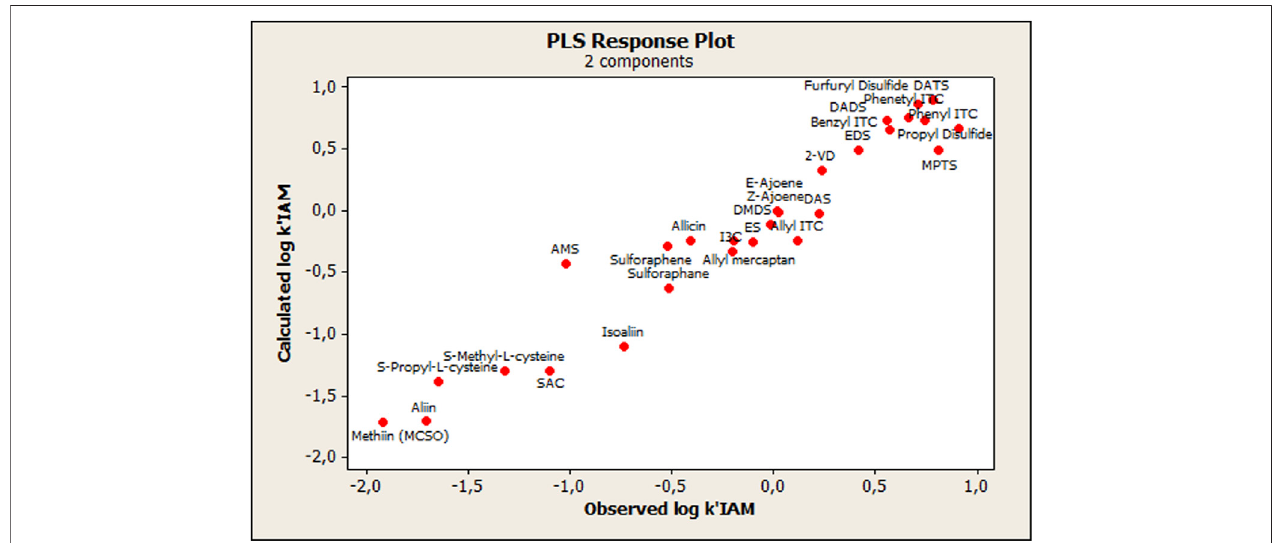
FIGURE 2 | Relationship between observed and calculated values using the PLS approach for log k ’ IAM.